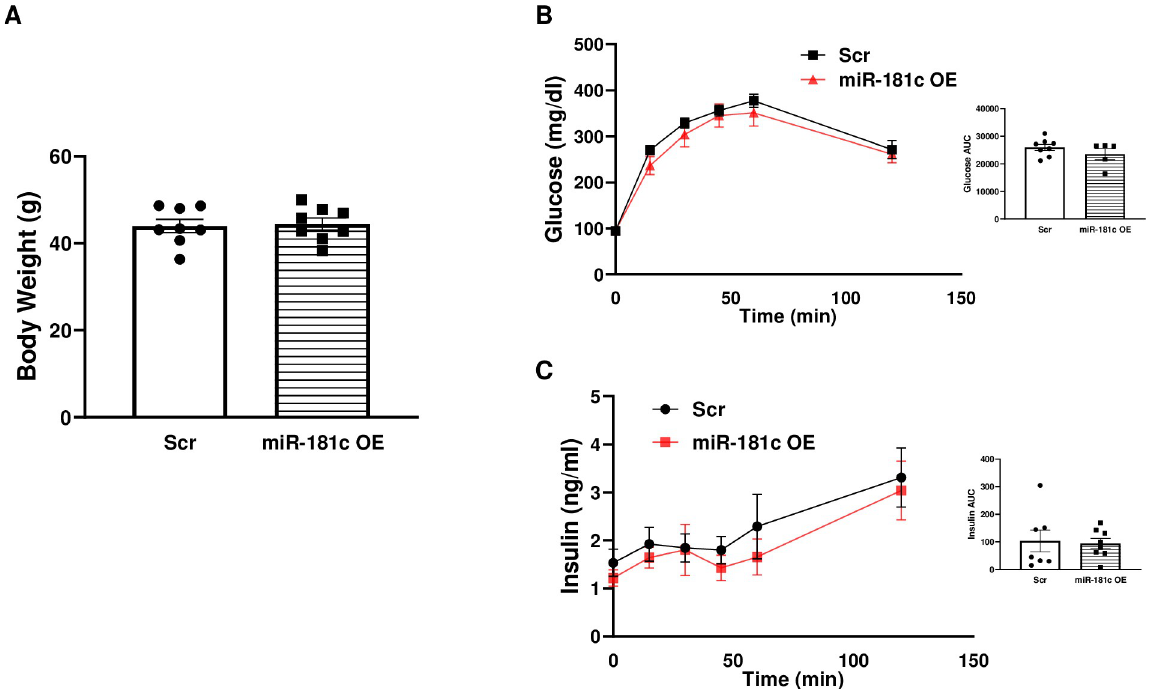
Fig 8. Effect of miR-181c overexpression in liver on insulin secretion. (A) Body weight. (B) Blood glucose and area under the curve during an IPGTT. (C) Plasma insulin levels and area under the curve during an IPGTT. OE, overexpression; Scr, scrambled oligonucleotide. Data are expressed as mean ± SEM; n = 8 per group. � p < 0.05 by Bonferroni post hoc analysis after intergroup differences were found by 2-way ANOVA.